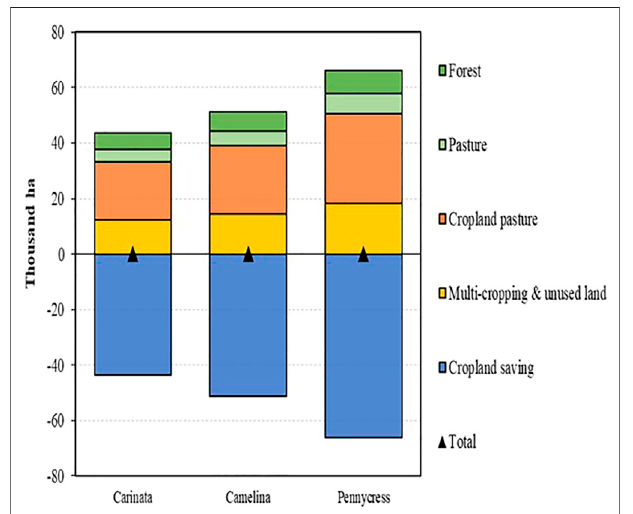
FIGURE 1 | ILUCs due to expansions in SAF from carinata oil, camelina oil, and pennycress (all by HEFA).